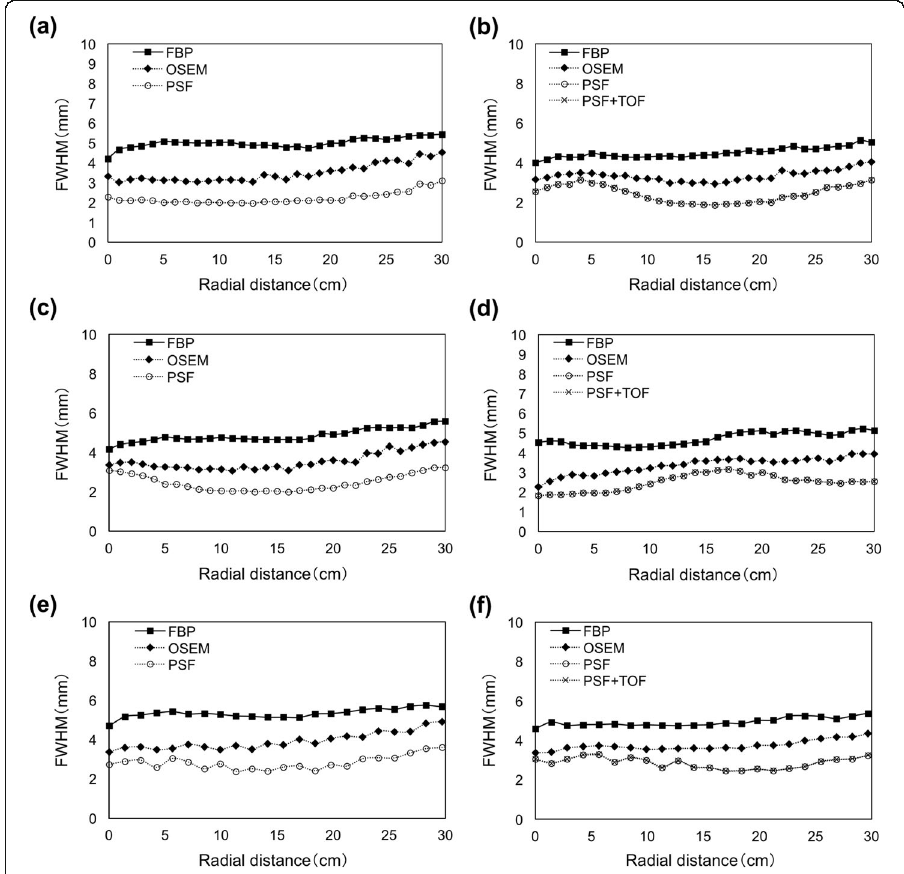
Fig. 3 Tangential FWHM at various moving radial locations for x - ( a , b ), y - ( c , d ), and xy - ( e , f ) axes using Discovery 600 ( a , c , e ) and Discovery 710 ( b , d , f